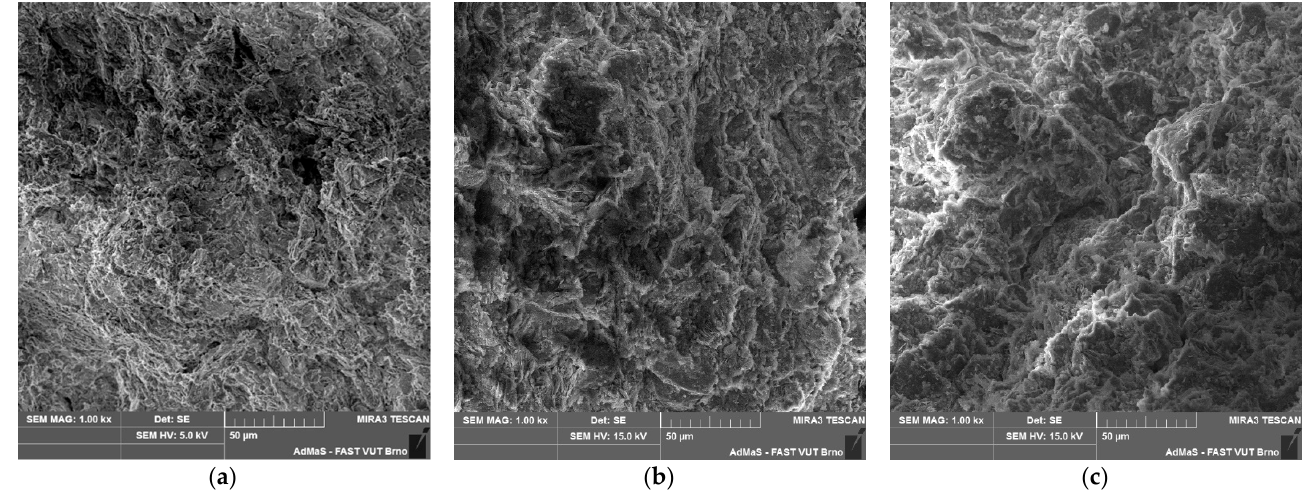
Figure 8. SEM of dried green bodies ( a ) mixture KQ; ( b ) mixture KQF; ( c ) mixture KQFF; magnification 1000×.